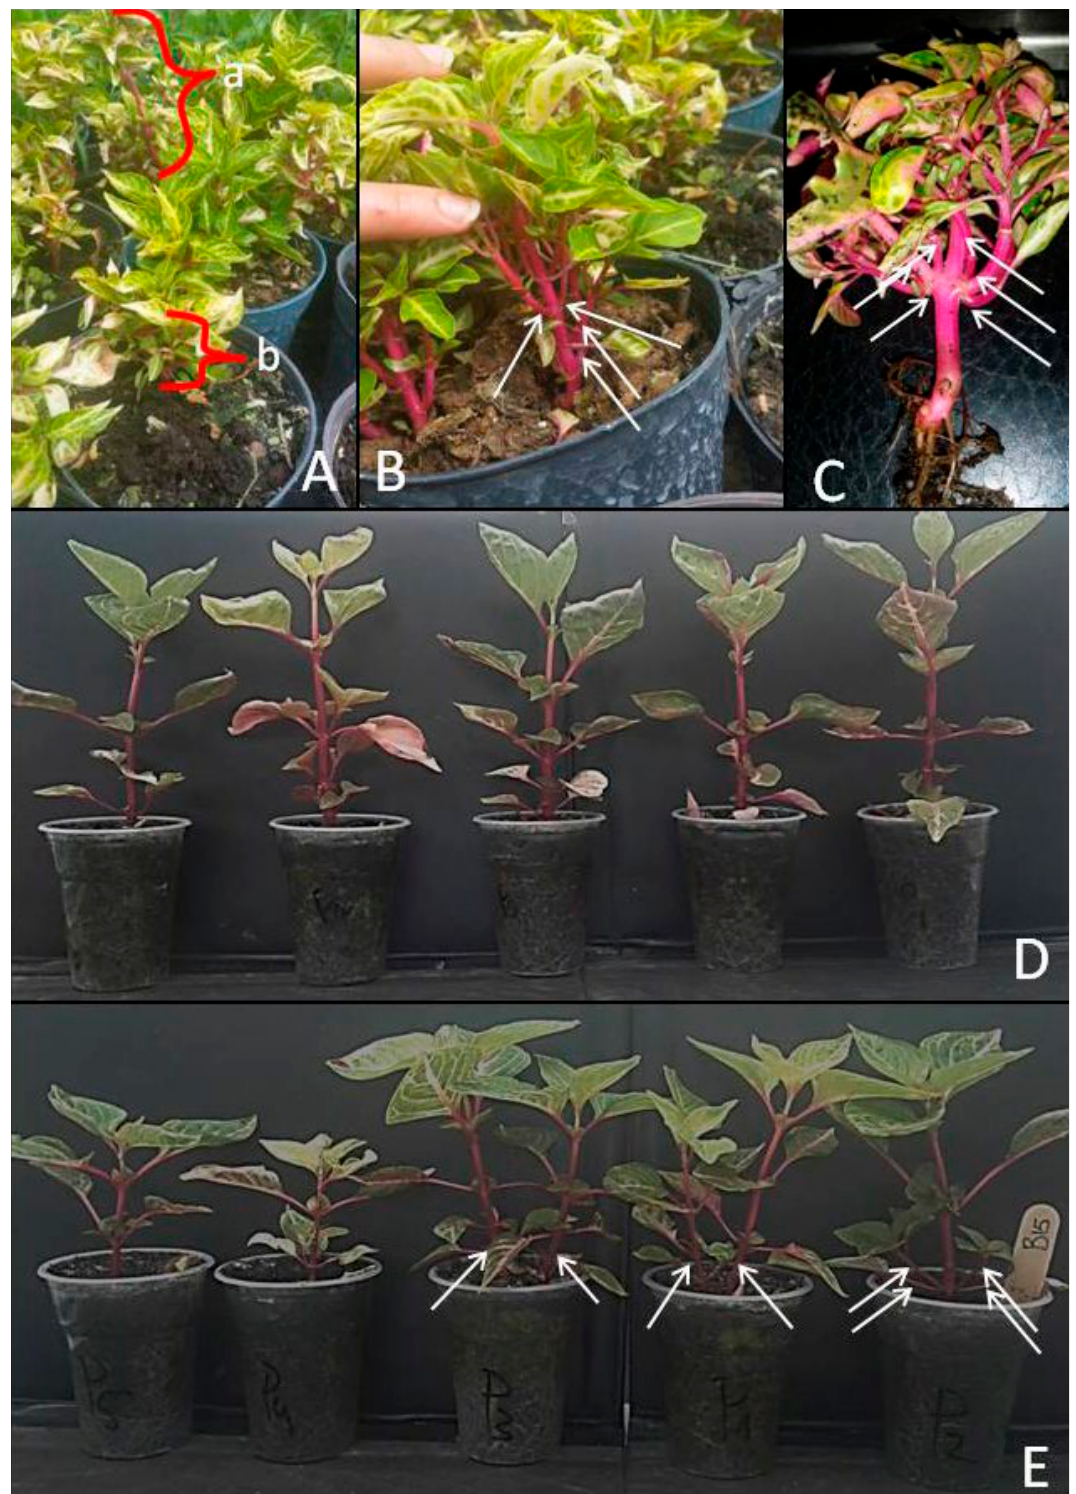
Figure 1. Symptomatic nursery-grown Iresine herbstii ‘Aureo-Reticulata’ plants were stunted (b), as compared to asymptomatic plants (a) (A), and exhibited stem proliferation (arrows) (B and C). Uninoculated control plants (D) developed single stems; plants inoculated with isolate 6 (E) developed multiple stems